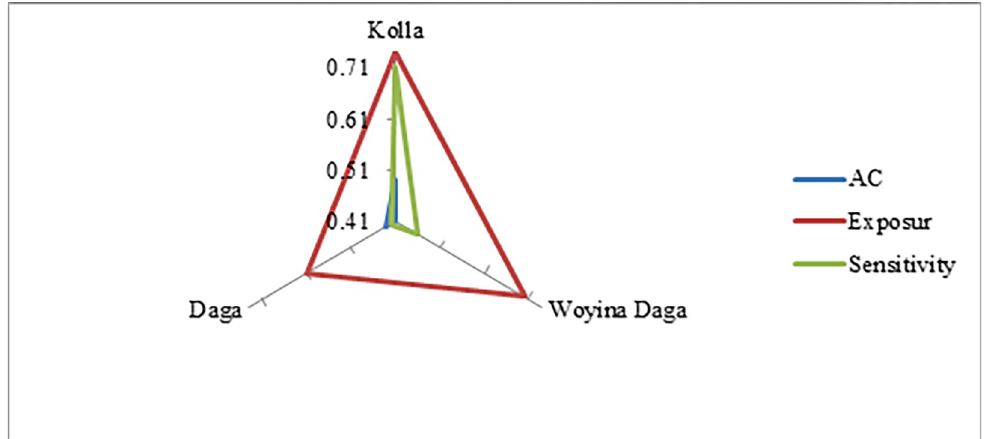
Fig 3. Vulnerability triangles of LVI-IPCC contributing